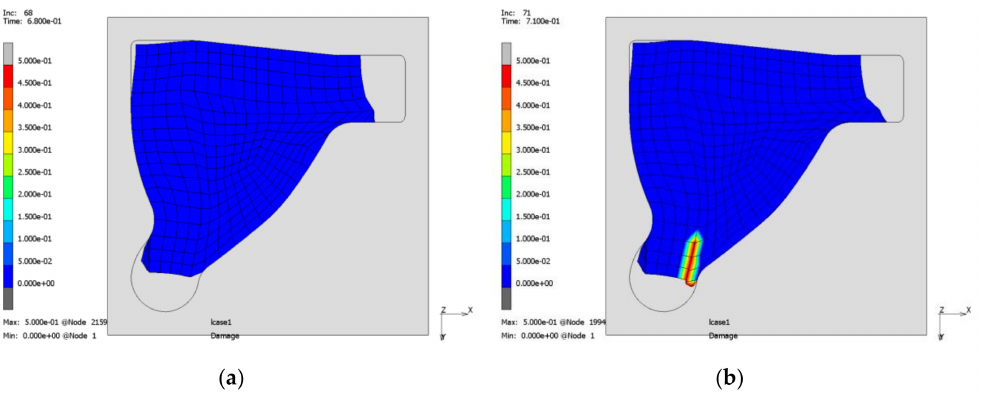
Figure 13. Forming process using a further simplified geometry; before ( a ) and after failure initiation ( b ): Joining zone damage.